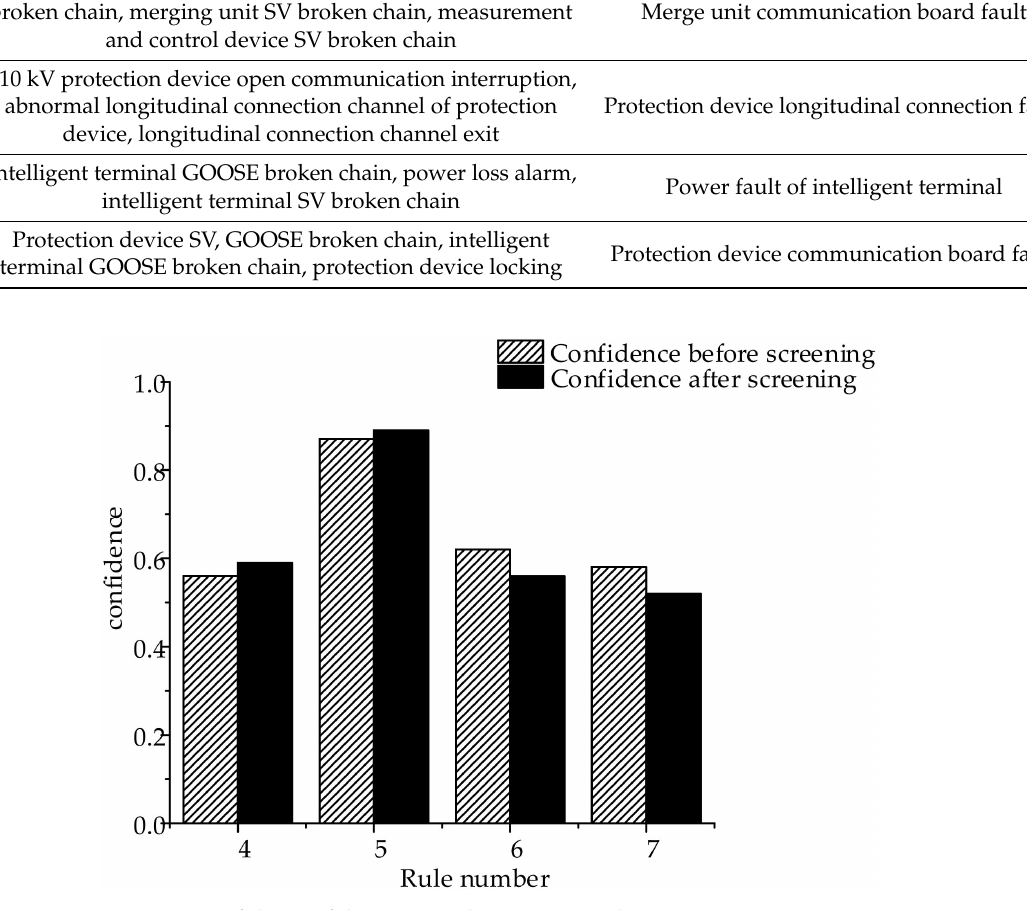
Figure 8. Confidence of the processed association